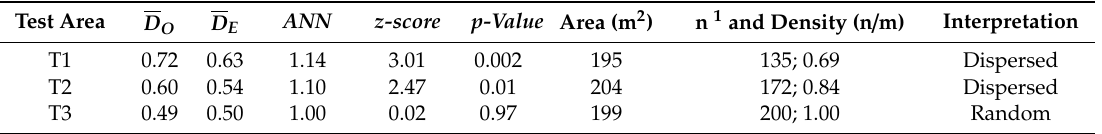
Table 2. Results of the Average Nearest Neighbour ( ANN ) statistics. ANN is the index described by Equation (2), the z-score is the ANN standard deviation and the p-value is the significance level of results, i.e., the probability that the null hypothesis (complete spatial randomness) is erroneously rejected. Interpretation assumes a confidence of